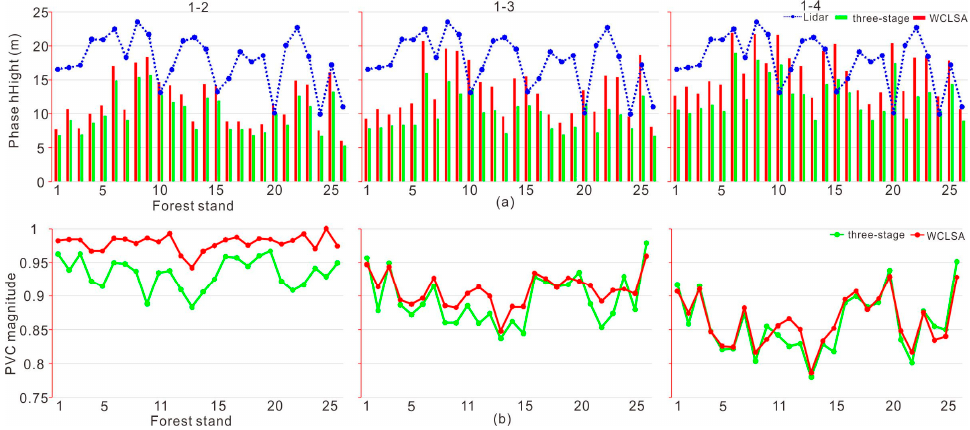
Figure 12. Average PVC phase height (bar graph) ( a ); and PVC magnitude ( b ) estimates of the 26 forest stands.